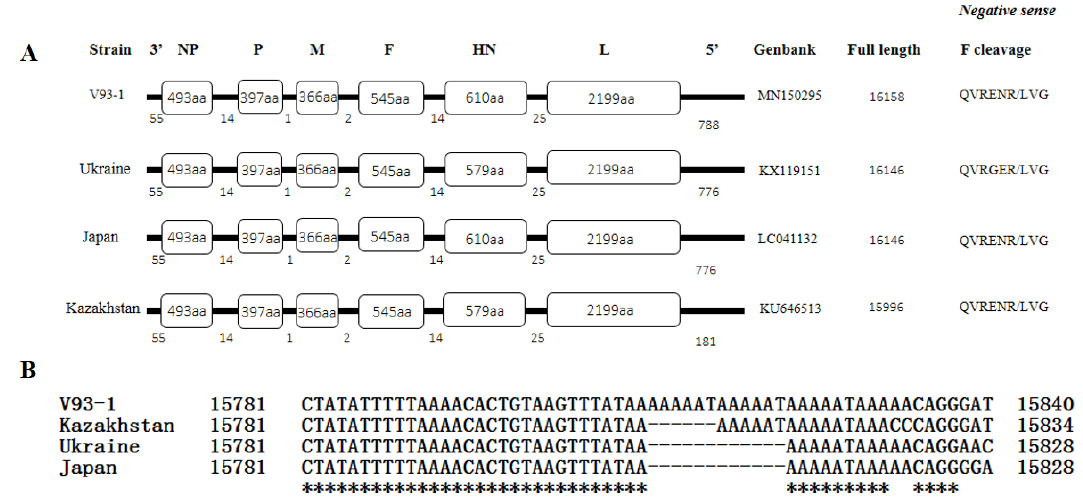
Figure 1. Genetic map ( A ) and alignment of the trailer regions ( B ) of AOAV-13 isolates used in the study. ( A ) Individual gene ORFs are indicated by rectangles. The amino acid length of each encoded protein is shown in each box, and the nucleotide (nt) lengths of the non-coding leader, intergenic, and trailer regions are shown under each map, and GenBank accession number, the total genome nt length and the sequence for the F0 protein cleavage site are shown in parentheses to the right. ( B ) Asterisk indicate identities and short-term indicate difference.